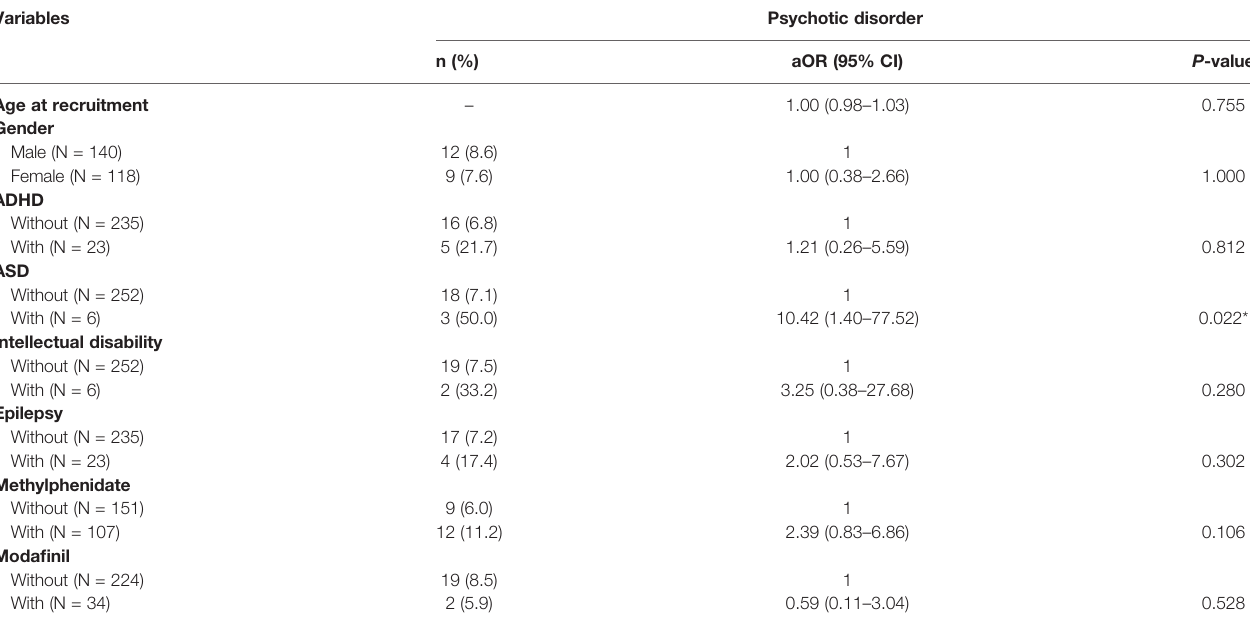
TABLE 3 | Risk factors of diagnosis with a psychotic disorder in narcoleptic